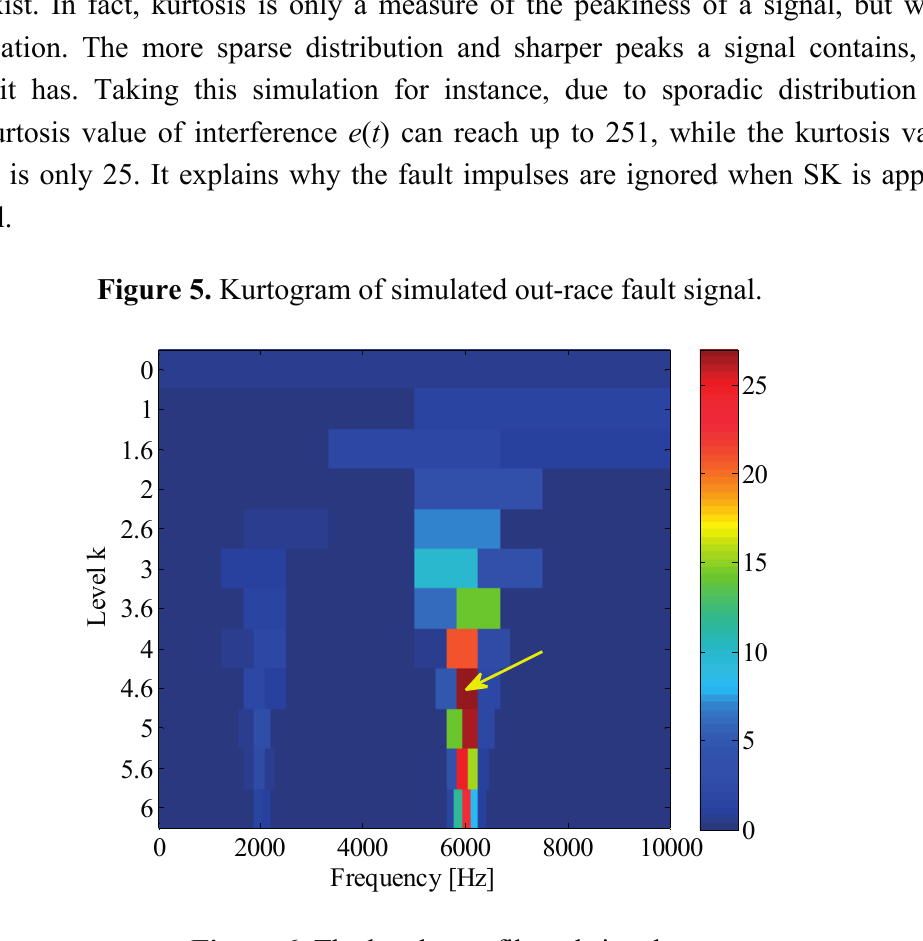
Figure 6. The band-pass filtered